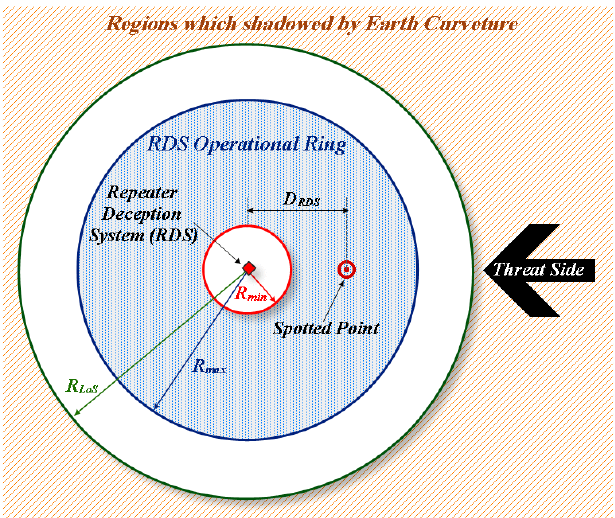
Figure. 4. The suggested arrangement of RDS in respect with targeted spot and threat